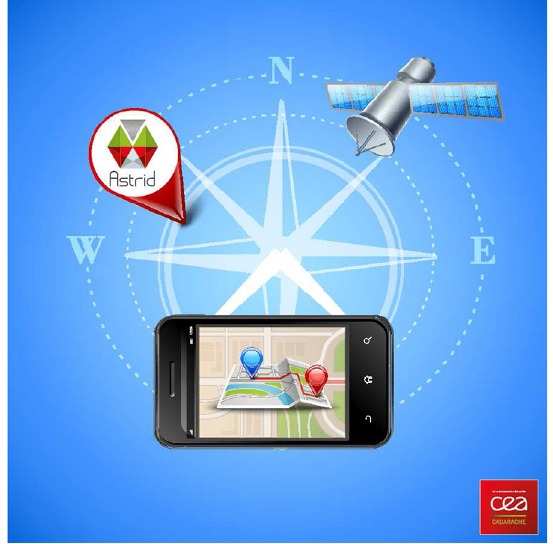
Fig. 1. Schematic basic idea of the ASTRID knowledge management